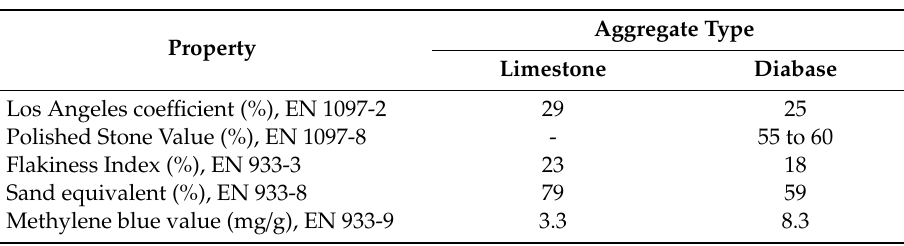
Table 2. Limestone and diabase aggregates’ characterization results.